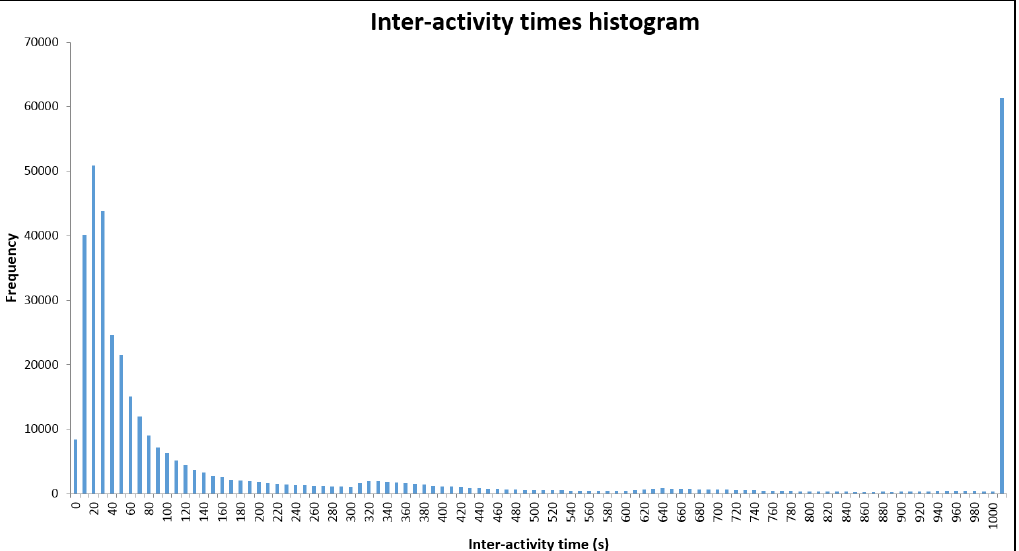
Figure 3. Histogram of inter-activity times.